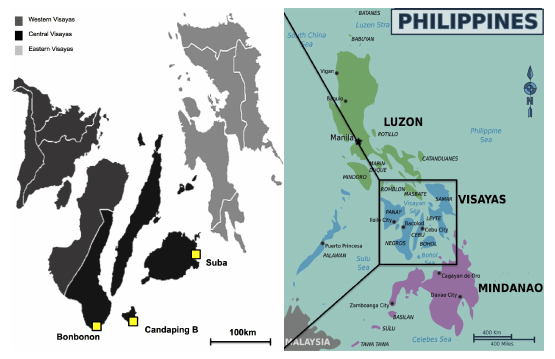
Fig. 2 . Map of the Visayas region of the Philippines, including the three research sites with estimated scale bars, and a broader map of the Philippines. Source: Wikitravel